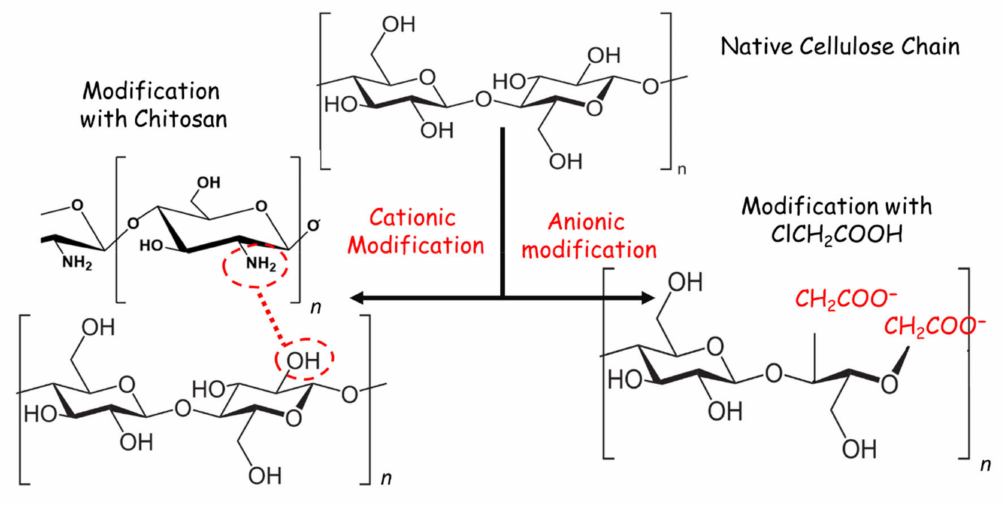
Figure 1. Schematic representation showing a surface modification of the cotton gauze using chitosan (Cs) (cationic modification) and monochloroacetic acid (MCA) (anionic